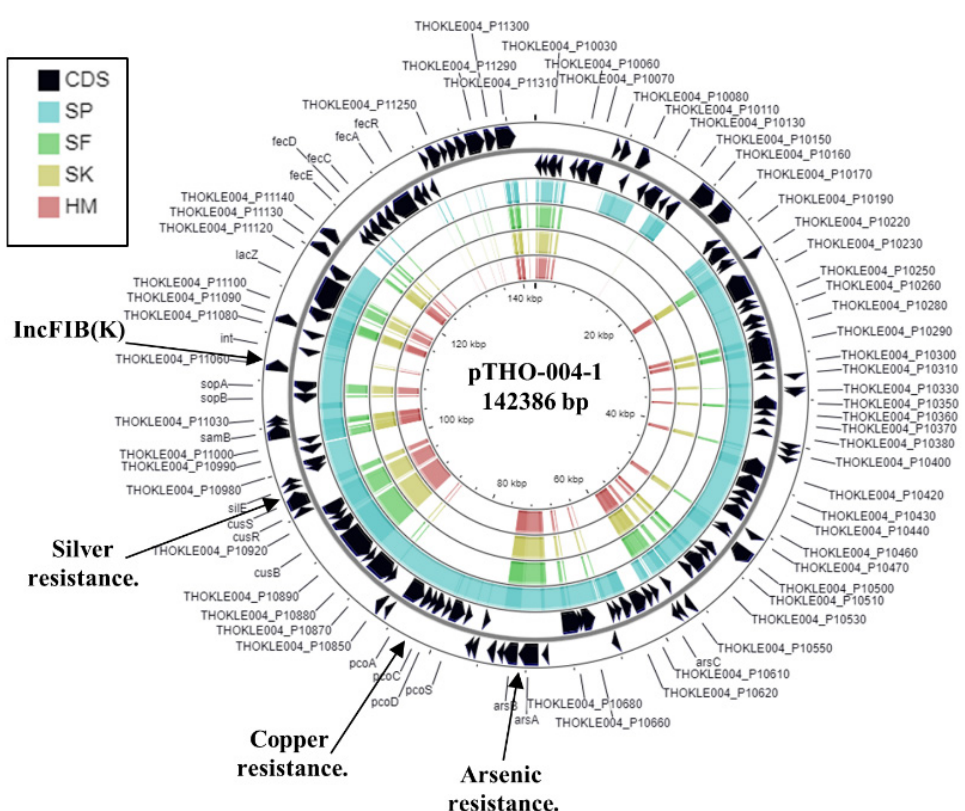
Figure 4. Analysis of the IncFIB(K) replicon carried by K. pneumoniae strain SP. The figure shows the comparison of K. pneumonia plasmid pTHO-004-1 (AP022528.1) with the genomes of K. pneumoniae strains SP, SF, SK, and HM, using GCview [32]. The outer two rings display the genes (CDS) on both strands, with the IncFIB(K) plasmid replicon and selected features labelled. The blue, green, gold, and red shading illustrates the BLAST results when the genome sequences of SP, SF, SK, and HM, respectively, are compared with pTHO ‐ 004 ‐ 1. Shaded regions indicate homology.